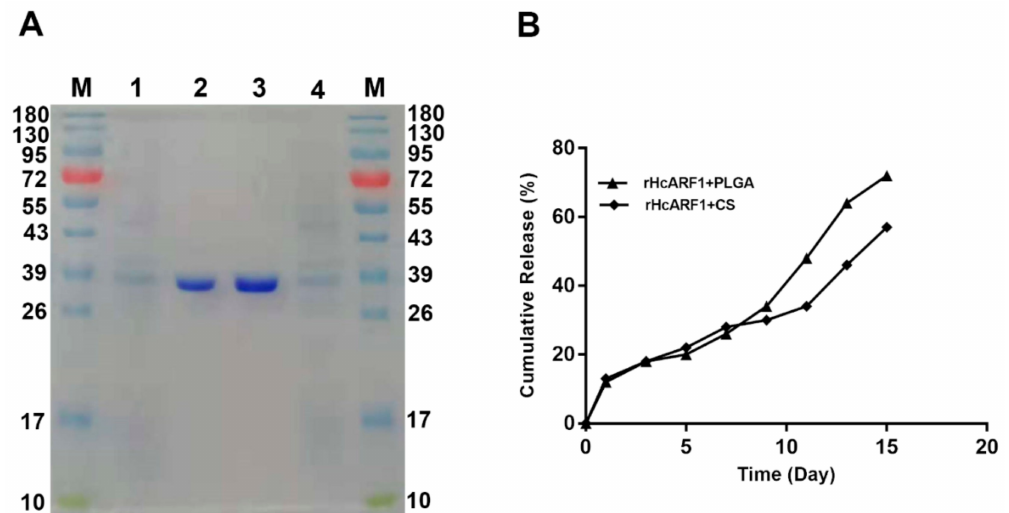
Figure 2. SDS-PAGE and cumulative release of antigen-loaded nanoparticles. SDS-PAGE of rHcARF1 entrapped in PLGA and CS NP. ( A ) Lane M: standard molecular weight protein marker, Lane 1: PLGA NP with unbounded rHcARF1. Lane 2: PLGA NP with bounded rHcARF1. Lane 3: CS NP with